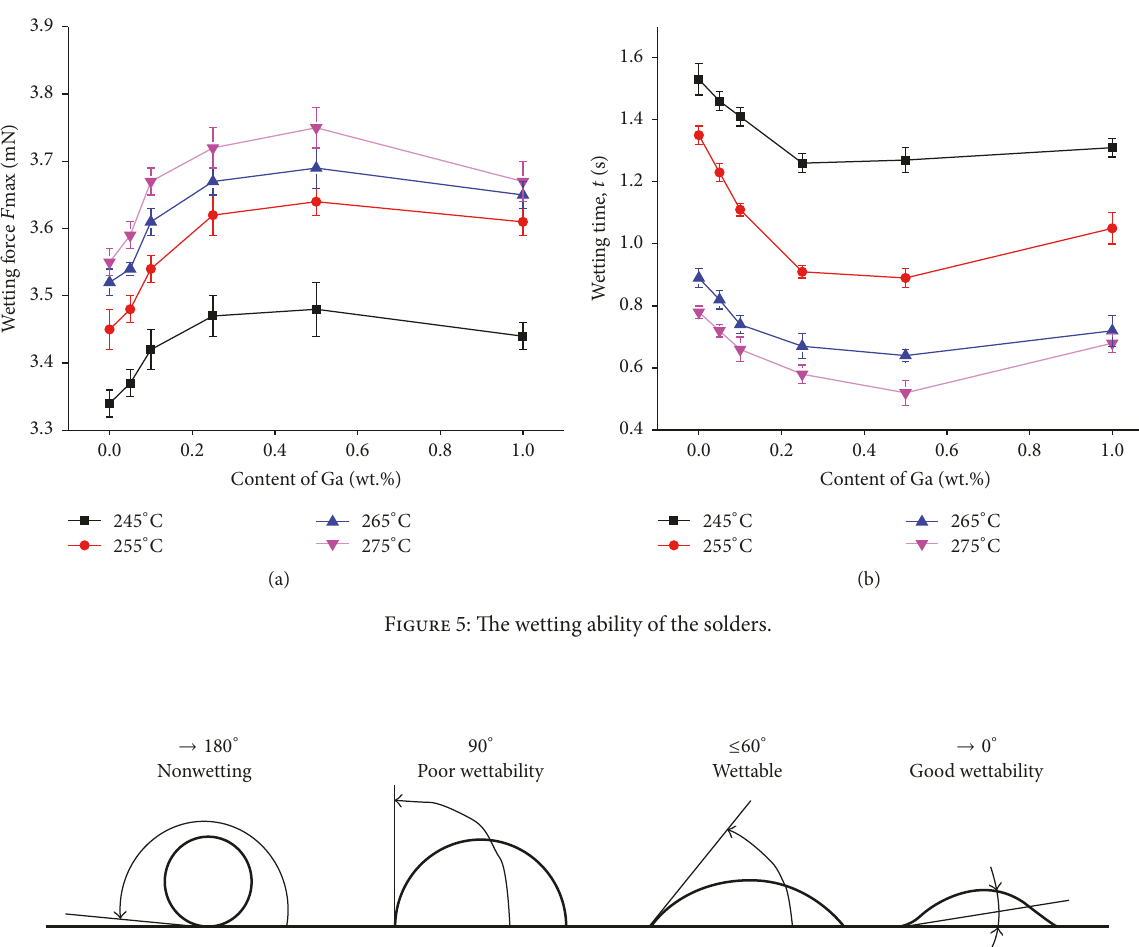
Figure 5: The wetting ability of the solders.